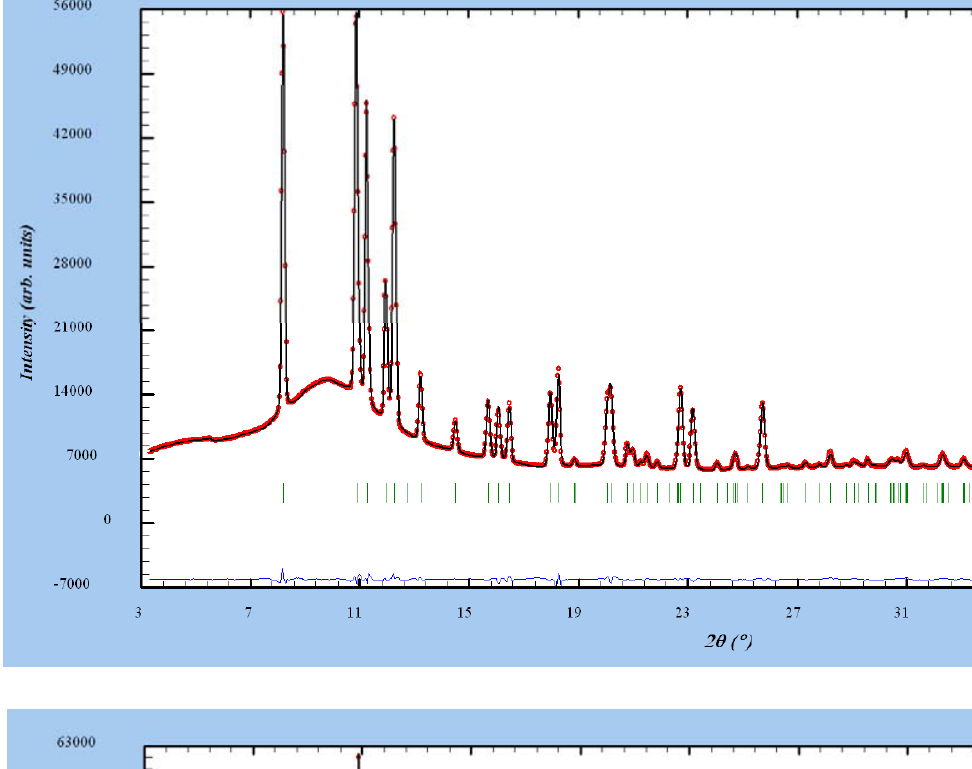
sample measured at 100 K 4